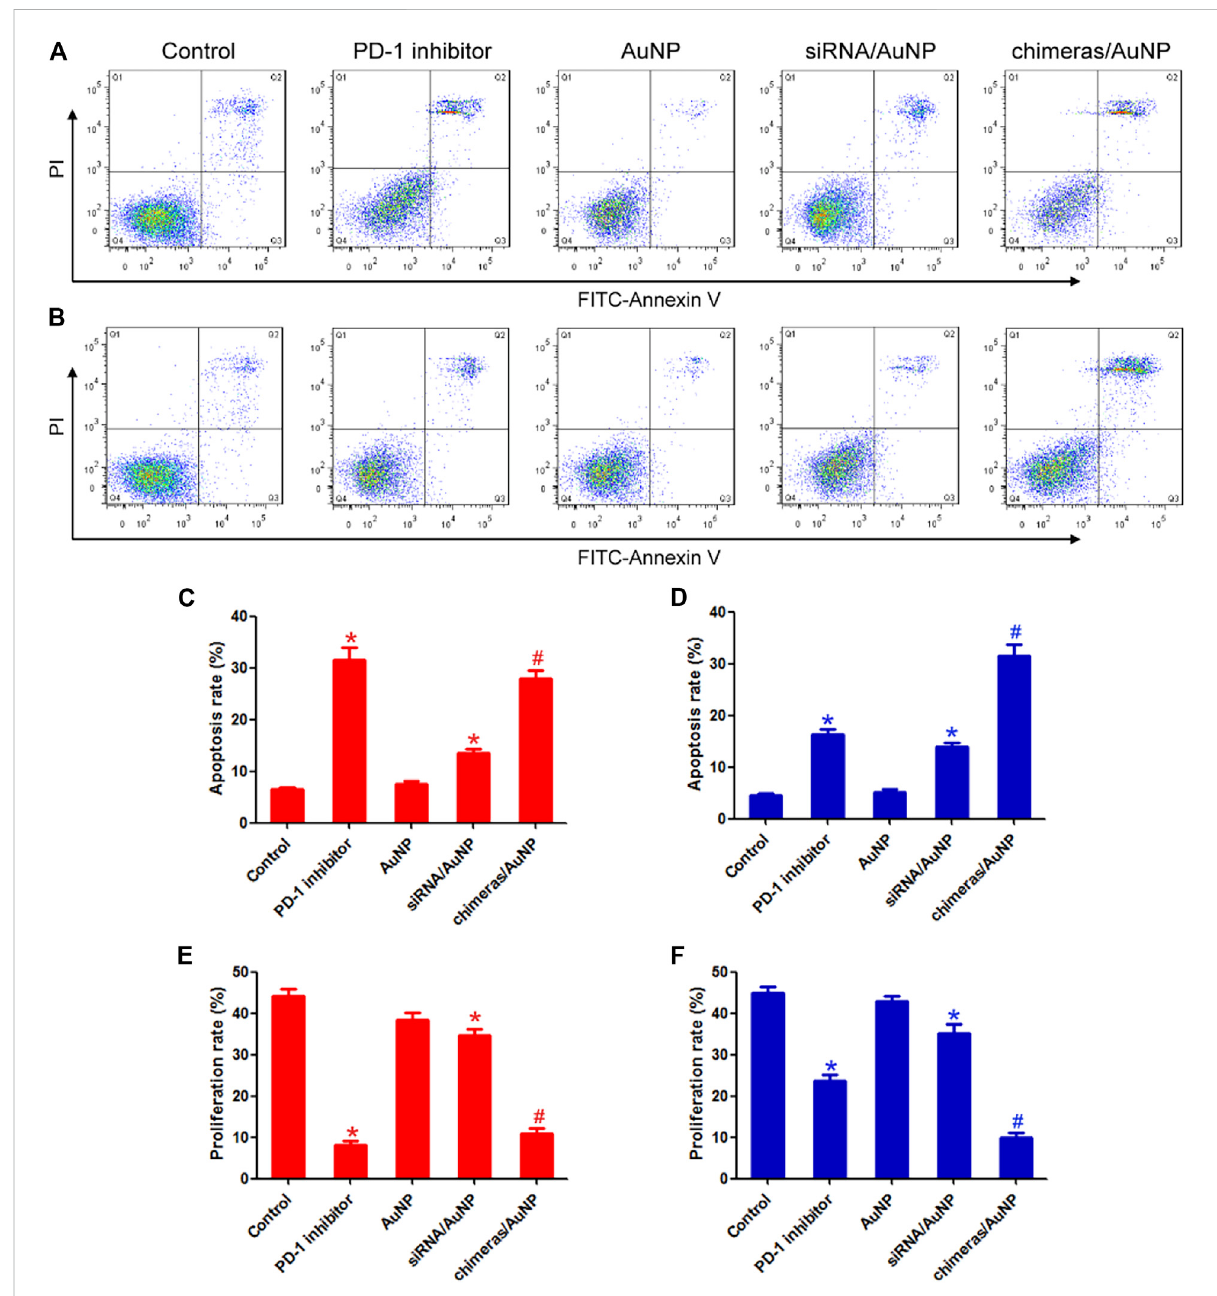
FIGURE 3 Chimeras/PEI/PEG/AuNPs continuously killed lung adenocarcinoma cells. After treatment for 48 h (A) or 96 h (B) , lymphocytes were collected and co-cultured with lung adenocarcinoma cells. Flow cytometry was used to detect cell apoptosis (C,E) After treatment for 48 h, there were no statistically signi fi cant differences in apoptosis rate and proliferation rate between the PD-1 inhibitor group and the chimeras/AuNP group (D,F) Compared with PD-1 inhibitor group, the apoptosis rate of lung adenocarcinoma cells in the chimeras/AuNP group was increased by 93.51% and the proliferation level was decreased by 58.46%. * p < 0.05 (n = 10) versus Control. # p < 0.05 (n = 10) versus siRNA/AuNP. Values are mean ± SD. Chimeras/PEI/PEG/AuNP/collagen membrane effectively treated malignant pleural effusion in vivo